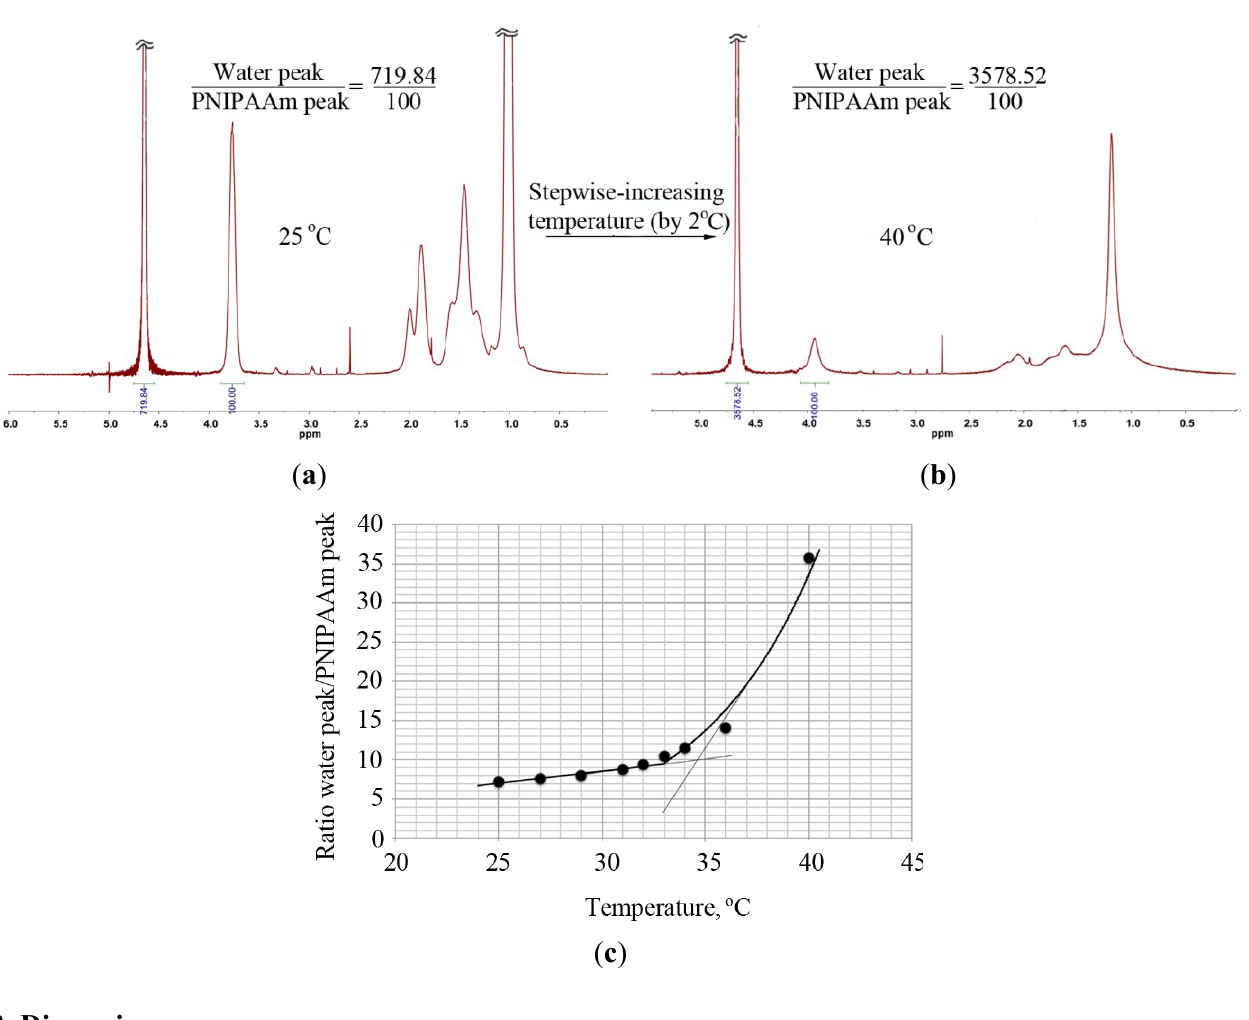
Figure 6. Determination of the LCST of PNIPAAm by 1 H-NMR. The ratio of the water 58 peak and the PNIPAAm peak at ~3.9 ppm was determined at measured temperature range (25–40 °C with increments of 2 °C) and plotted as a function of temperature. The intersection of a line drawn through the baseline and through the leading edge of the curve determined the transition temperature. 1 H-NMR of PNIPAAm at ( a ) 25 °C and ( b ) 40 °C and ( c ) the ratio of the water peak and the PNIPAAm peak plotted as a function of